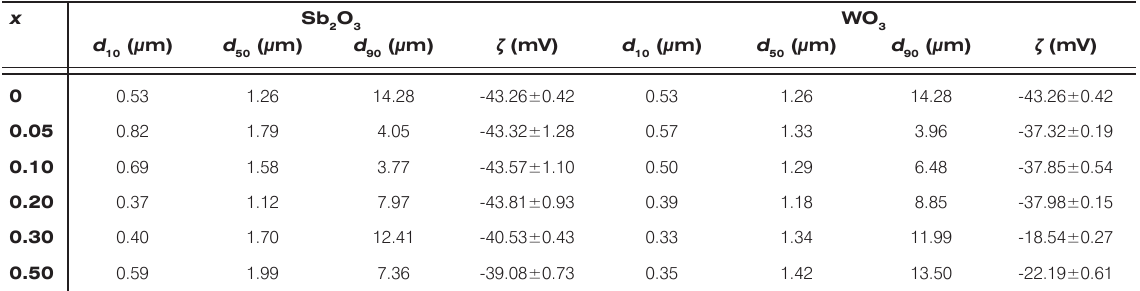
Cr M O prepared at calcination temperature 1050°C. 1-3x x 2x 2